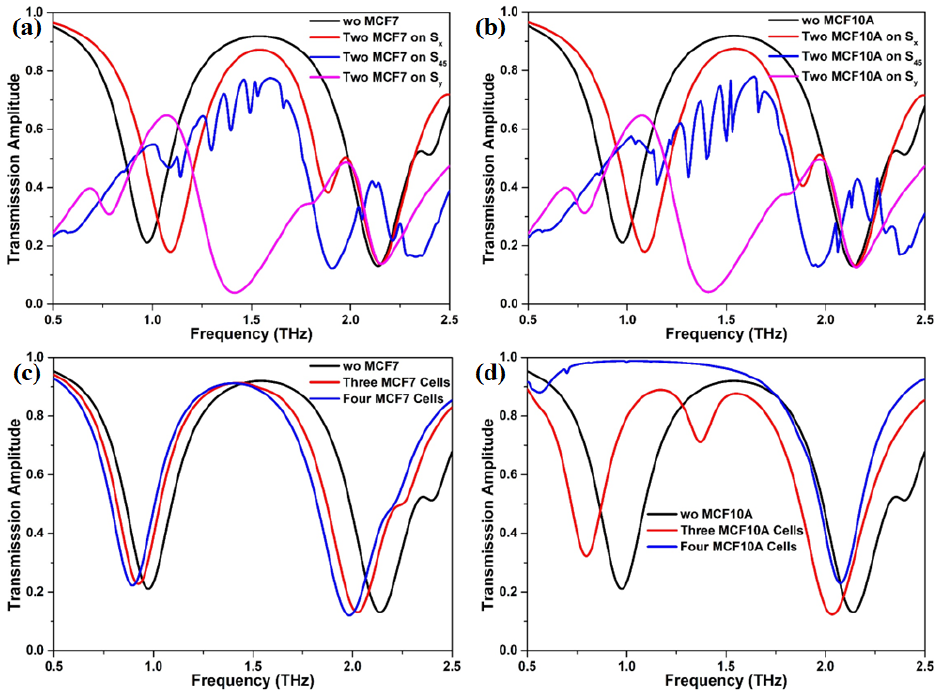
Figure 6. The corresponding transmission spectra of the proposed metasurface with ( a ) two MCF7, ( b ) two MCF10A, ( c ) three and four MCF7, and ( d ) three and four MCF10A. Table 1. Characteristics of the proposed graphene metasurface without and with breast